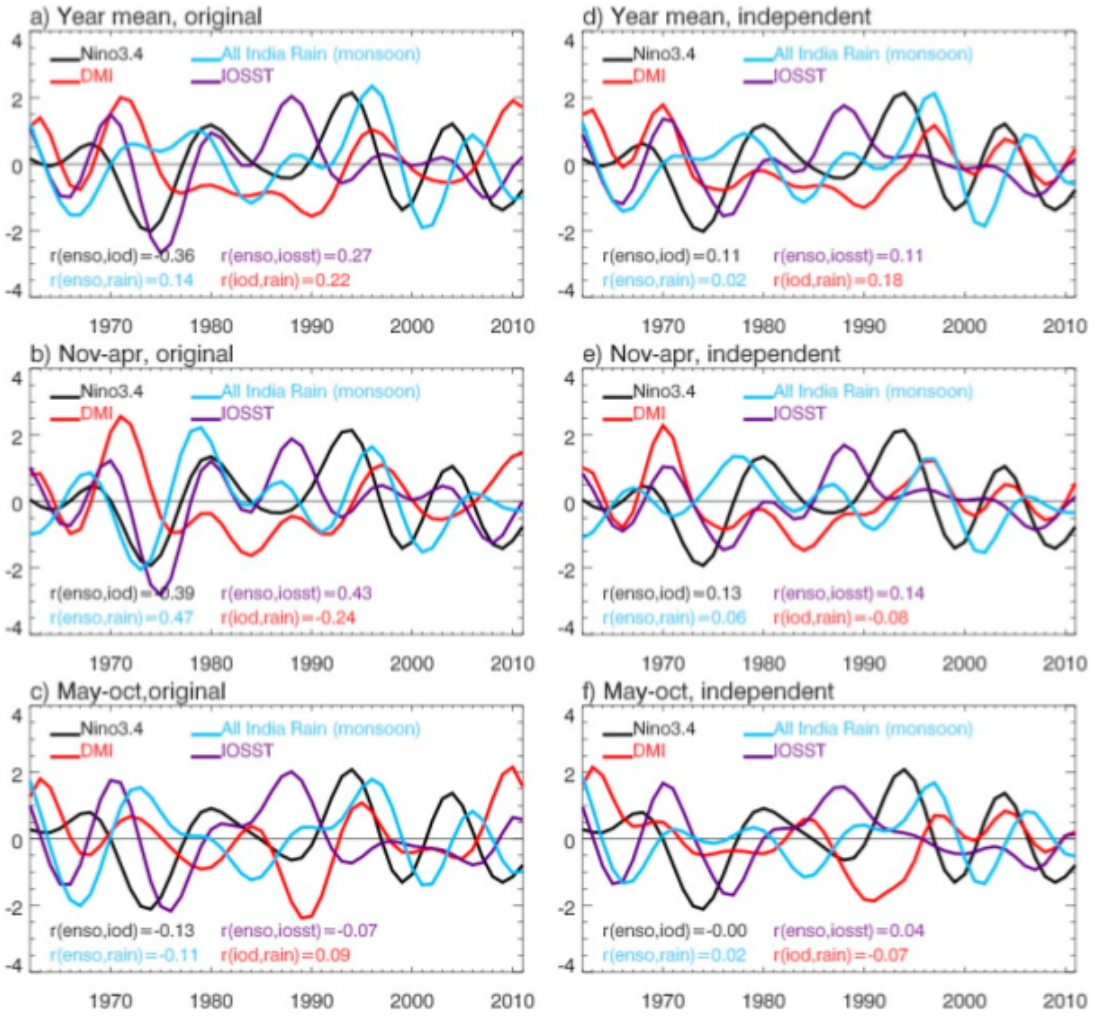
Figure 1. ( a ) The 8 year low-passed climate indices based on the annual mean Nino3.4 index, Indian Ocean Dipole (IOD) Mode Index (DMI), and the annual total of all India monsoon rainfall (mm) index, and the Indian Ocean SST (IOSST) index; ( b ) same as ( a ) but based on winter (November–April) data; ( c ) same as ( a ) but based on summer (May–October) data. The 1962–2011 linear trend is removed and each index is normalized by its standard deviation (STD). Panels ( d – f ) are the same as ( a – c ), except for removing the El Niño–Southern Oscillation (ENSO) effect on the DMI, monsoon, and IOSST, and removing the monsoon effect on the DMI, using Bayesian dynamical linear model (DLM;